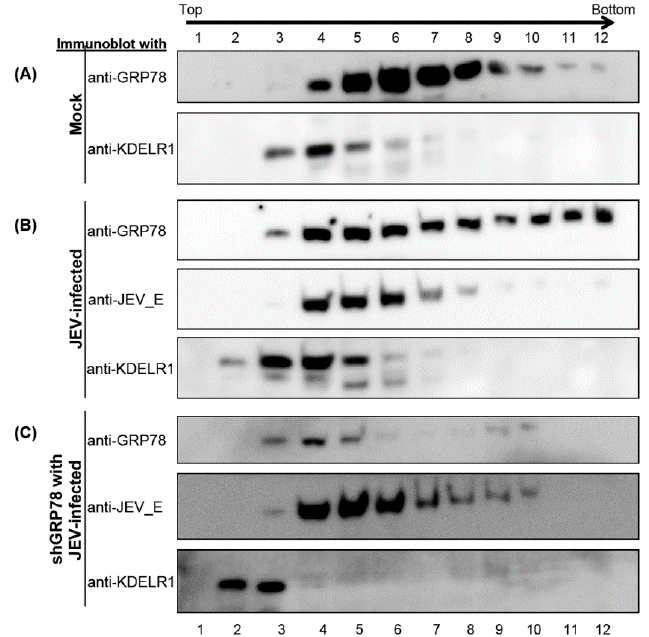
Figure 4. Co-purification of GRP78, KDELR and viral E protein from the JEV-infected cells. The BHK-21 cells were mock-infected or infected with JEV at the MOI of 0.1, and the cells were harvested by freeze-and-thaw for the disturbing of the cell membranes. The lysates were then subjected to a 30% sucrose cushion for the removal of nonspecifically interacting proteins from the virions. The JE viral particles were purified by isopycnic fractionation using a 20% to 60% linear sucrose density gradient. The JE viral E, GRP78 and KDEL receptor proteins were detected in the fraction by Western blotting using anti-JEV_E, anti-GRP78 and anti-KDELR1 antibodies, respectively. ( A ) Mock, BHK-21 cells with mock-infected; ( B ) JEV-infected, BHK-21 cells with JEV infection; ( C ) shGRP78 with JEV-infected, the GRP78 knocked down cells infected with